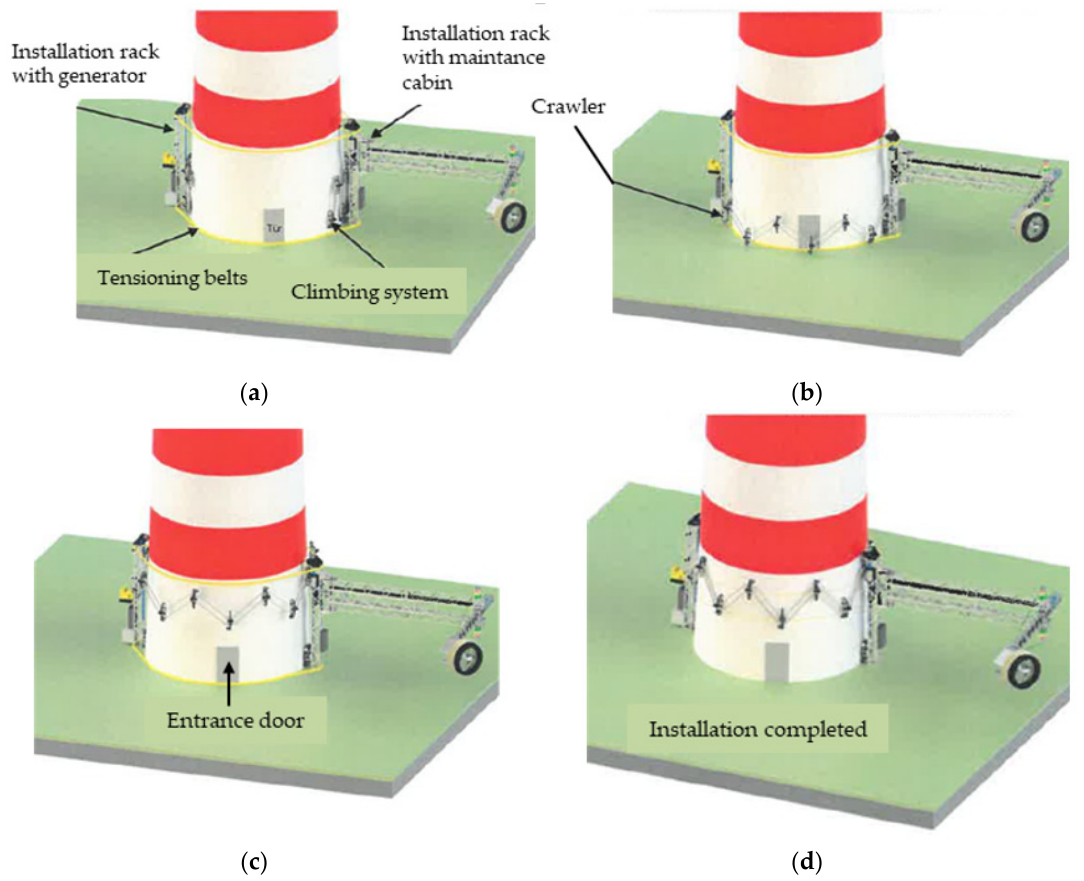
Figure 14. Steps of the CRR installation ( a ); step 2 ( b ); step 3 ( c ); installation completed ( d ).